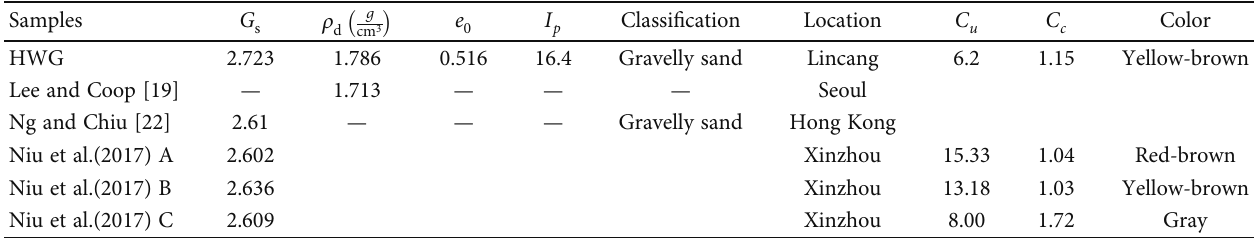
Table 1: Basic physical properties and mechanical indices of weathered granites (date from Lee and Coop [19], Niu et al. [21], and Ng and Chiu [22]).